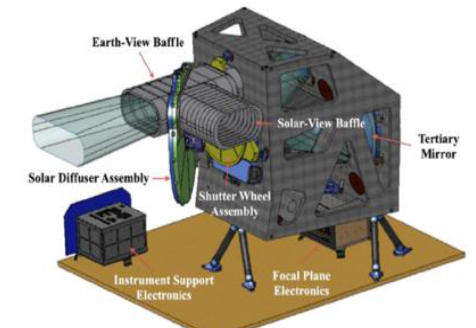
Figure 5. Configuration of OLI (D.P.Roy, 2014a)